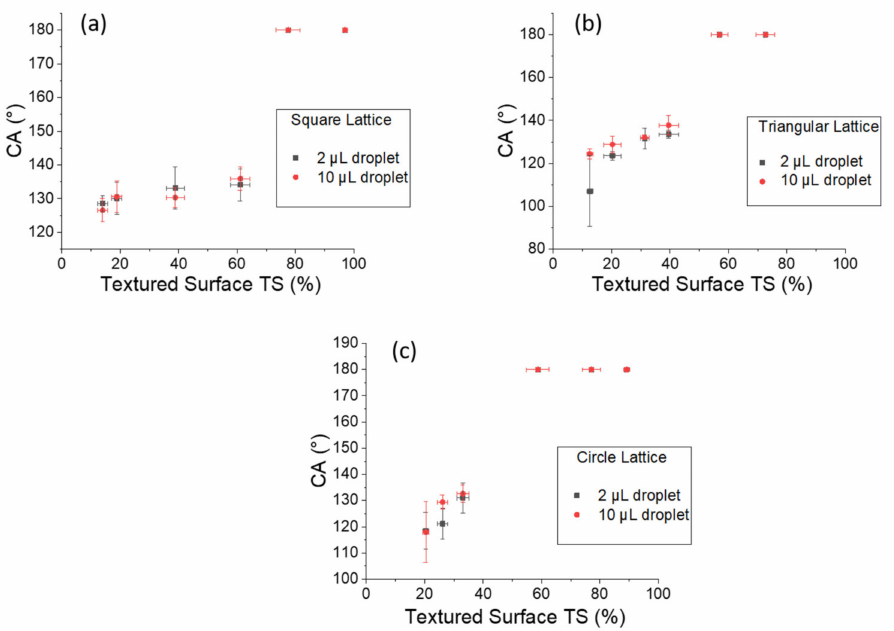
Figure 6. Evolution of the contact angle (CA) as a function of the textured surface percentage for 2 and 10 µ L droplets: ( a ) square lattice, ( b ) triangle lattice, ( c ) circle